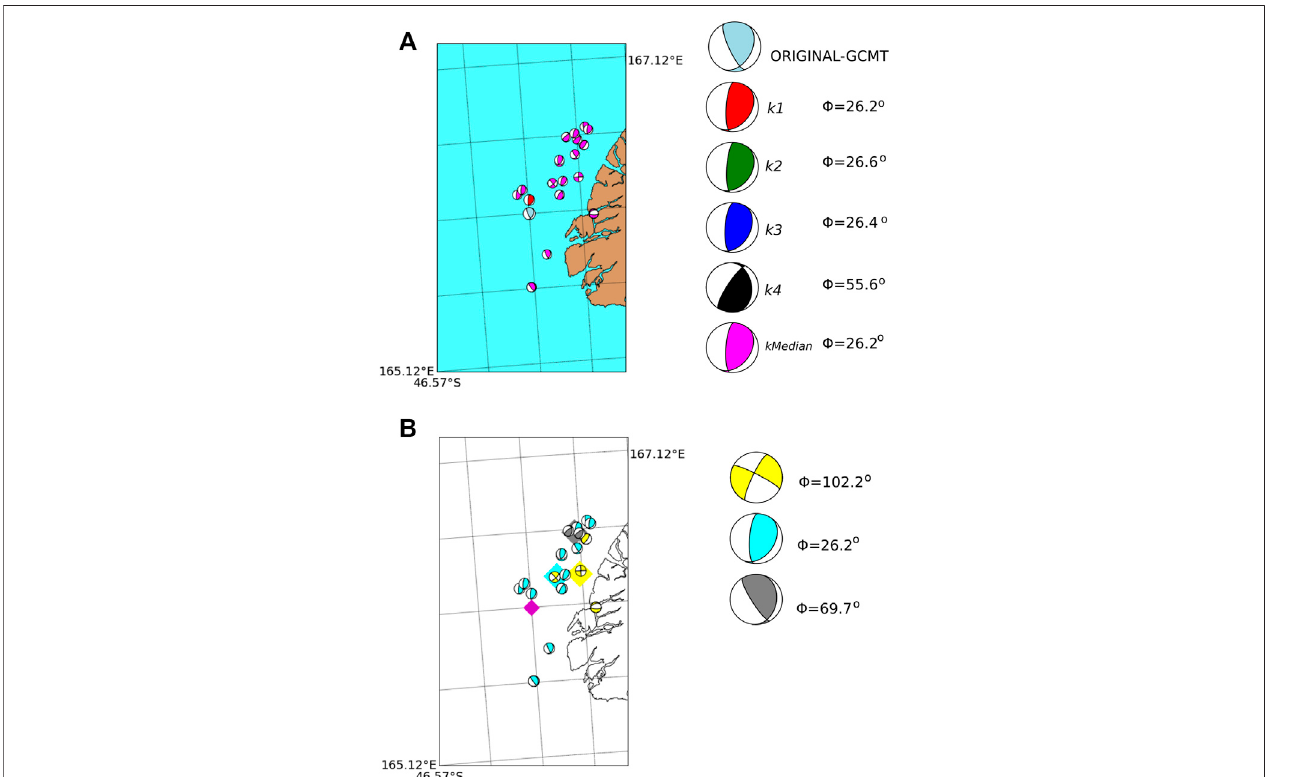
FIGURE 8 | (A) Nearest neighbor solutions for a particular example in New Zealand (see Table 3 ). The map shows the location and focal mechanism of the test event (light-blue) and its neighbors. From closer to farther solutions, k 1 (red beachball), k 2 (green), k 3 (dark-blue), k 4 (black), and k − median (magenta). The MRA values Φ ,listedtotheright,measurethedifferencesbetweeneachneighborandthetesteventsolution. (B) DBSCANresultsforthesameearthquakeof Figure8A inlight-blue. The magenta diamond indicates its epicentral location. The beach balls with the same color belong to the same cluster de fi ned by the DBSCAN algorithm. The centroids of each cluster are shown in diamond markers of the corresponding color. Those centroids are computed as the mean value of the latitude, longitude and depth from each event in the cluster. At the right side the median FM solutions computed in each cluster are shown. The MRA value Φ relative to the test-event is also